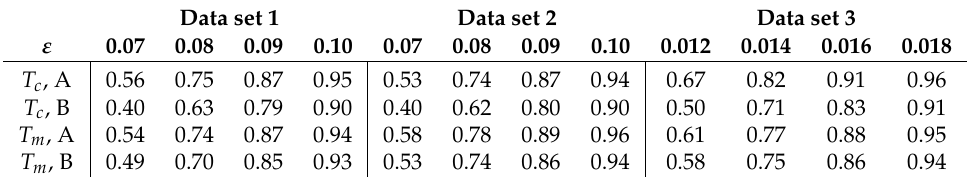
Table 3. Simulated rejection probability of the equivalence tests at the nominal level 0.05. The rejection probability is simulated for different values of the tolerance parameter ε at the HWE distributions e ( p n ) , which are implied by data sets 1, 2 and 3. The sample size equals the size of the corresponding data set. The number of replications is 1000 for each experiment. A stands for the asymptotic test and B stands for the bootstrap test.